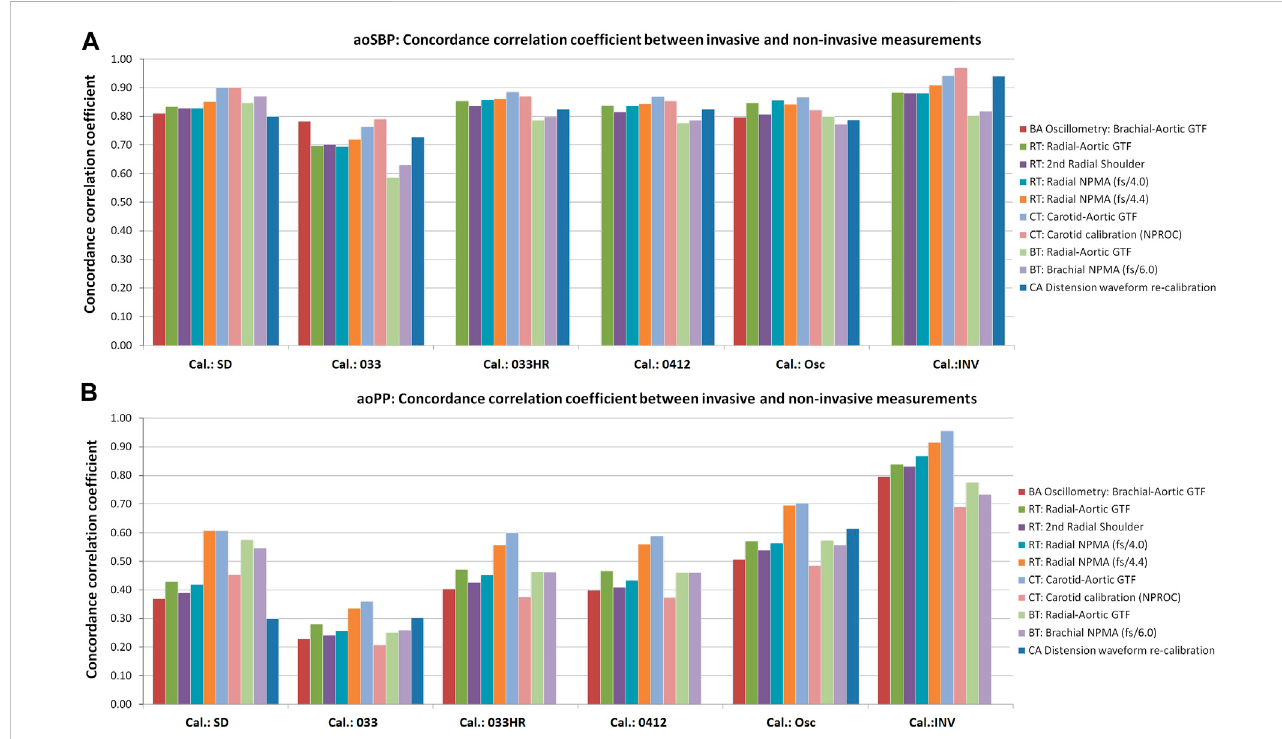
FIGURE 2 Concordance correlation coef fi cients (CCC) between invasive and non-invasive aoSBP (A) and aoPP (B) measurements. Detailed 95% con fi dence intervals for the CCC values are presented inSupplementary File S2 (Tables S6,